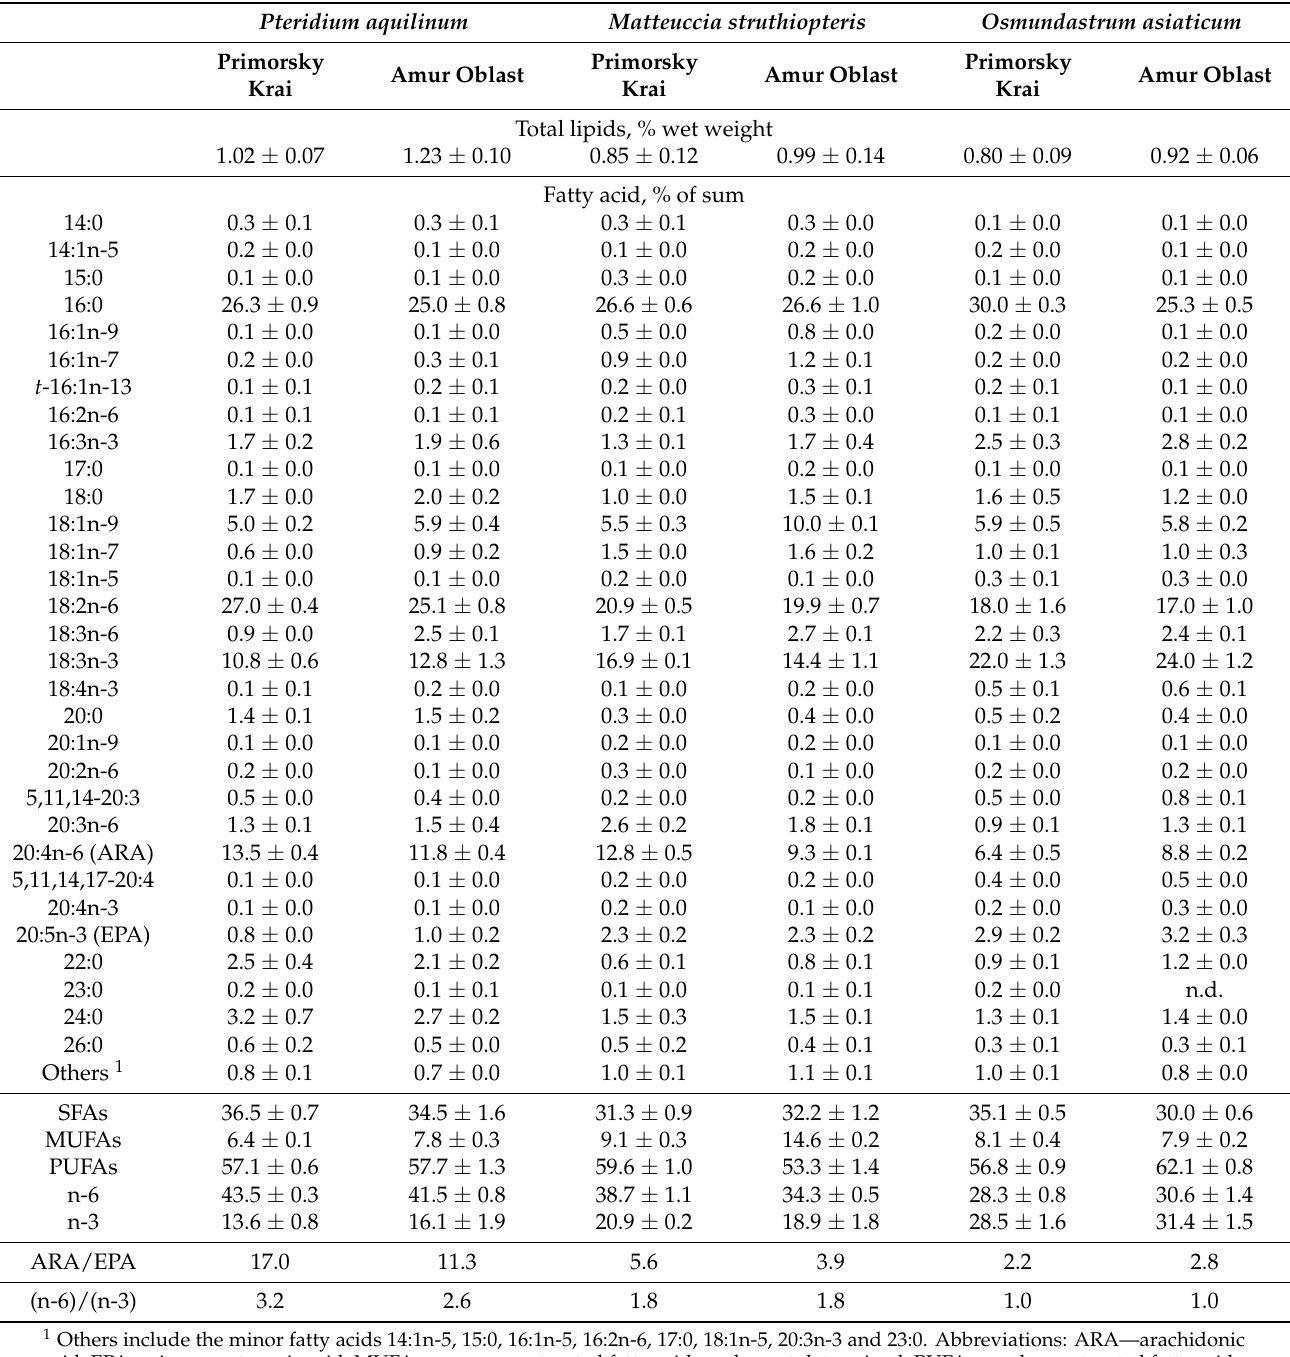
Table 1. Lipid and fatty acid content in the raw fiddleheads of edible ferns obtained from the Russian Far East. Pteridium aquilinum